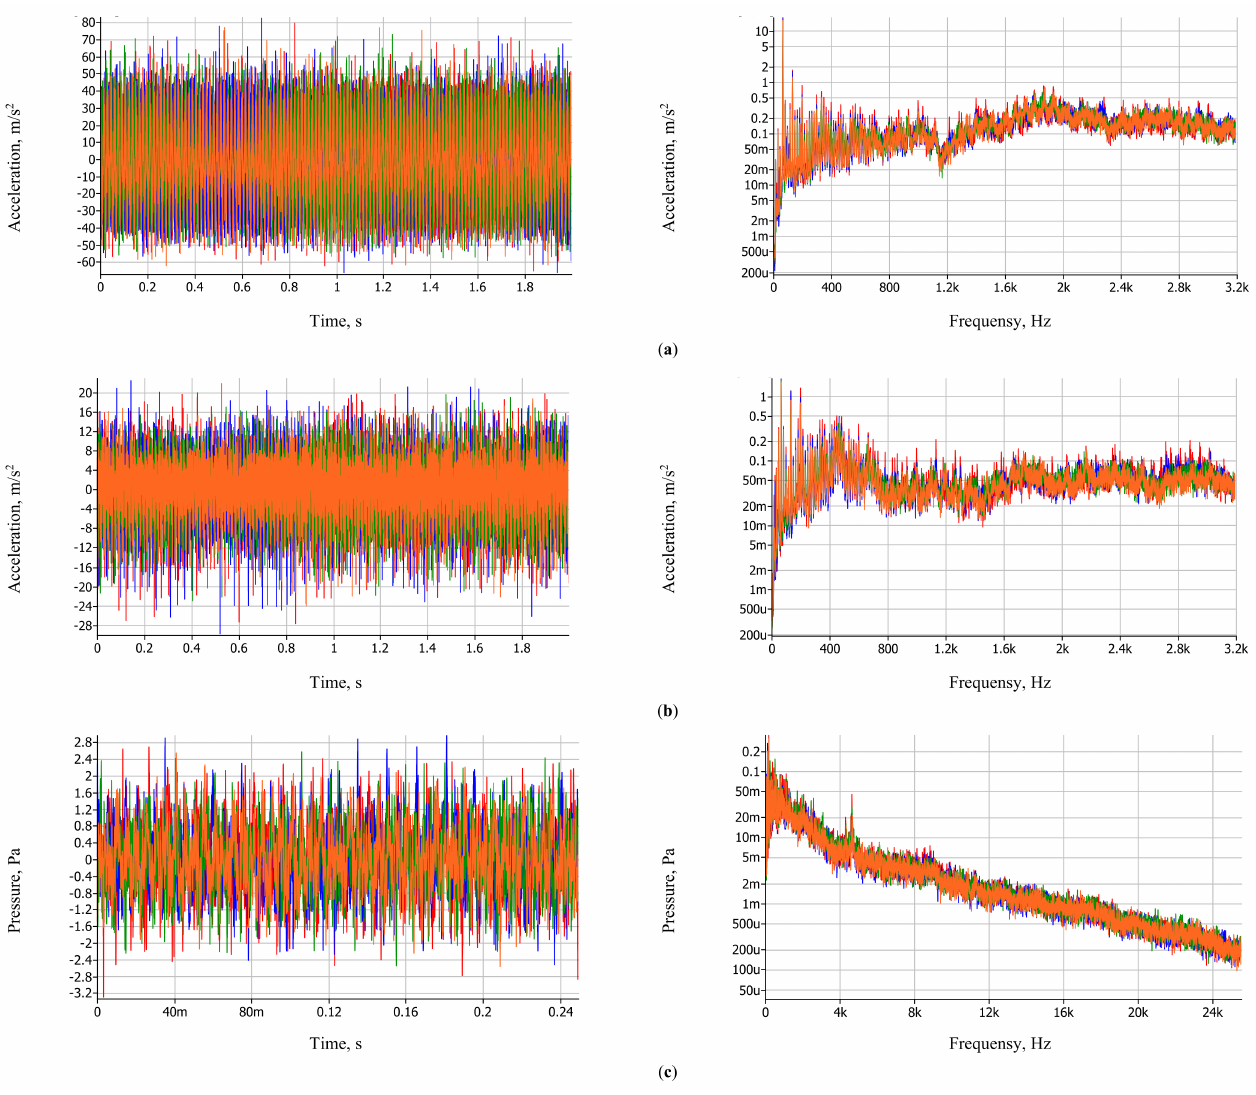
Figure 4. Results of vibrations and sound pressure at optimal ST for mixture. Fuel mixtures marked in: red—100CH 4 , blue—80CH 4 _20CO 2 , green—60CH 4 _40CO 2 , orange—50CH 4 _50CO 2 . ( a )—Vibration acceleration time and spectrum characteristic in the vertical direction, ( b )—Vibration acceleration time and spectrum characteristic in the longitudinal direction, ( c )—sound pressure and spectrum